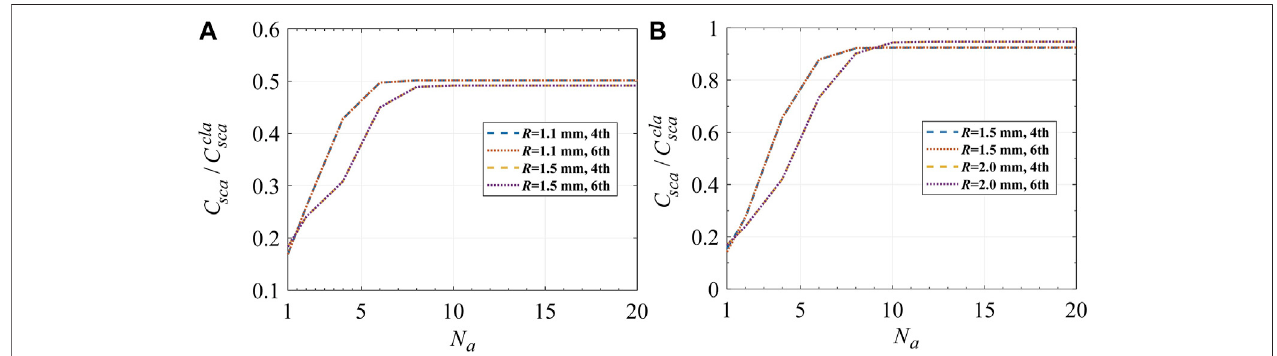
FIGURE7 | Convergence ofthe scattering cross section versusthe number ofiterations and N a . The ratioof scattering cross section calculated under the multiple scattering method to the results calculated with the classical assumption for (A) two-particle clusters and (D) four-particle clusters with different separations between particles indicated by the distance R from the center point of the cluster to an individual